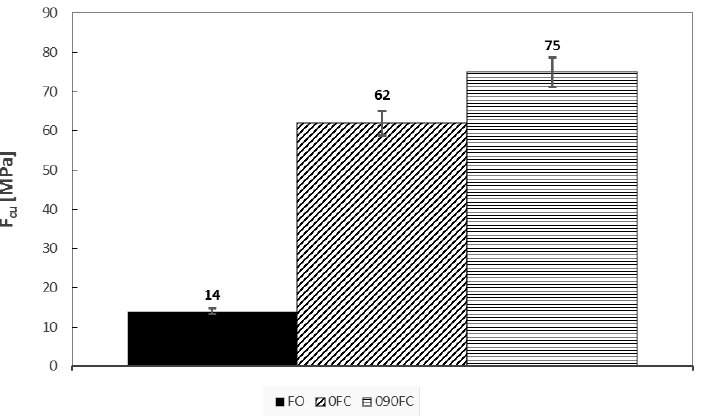
Figure 7. Final tensile strength for all systems.